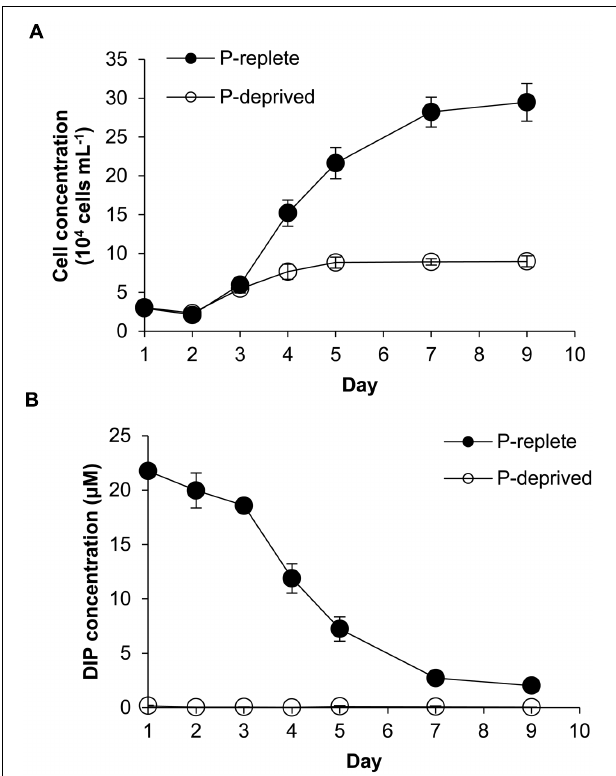
FIGURE 1 | Growth curves (A) and dissolved inorganic phosphorus (DIP) concentrations (B) in the Amphidinium carterae cultures under the P-replete and P-deprived conditions in the 9-day experimental period. Shown are means ± standard deviations (error bars) from the triplicated